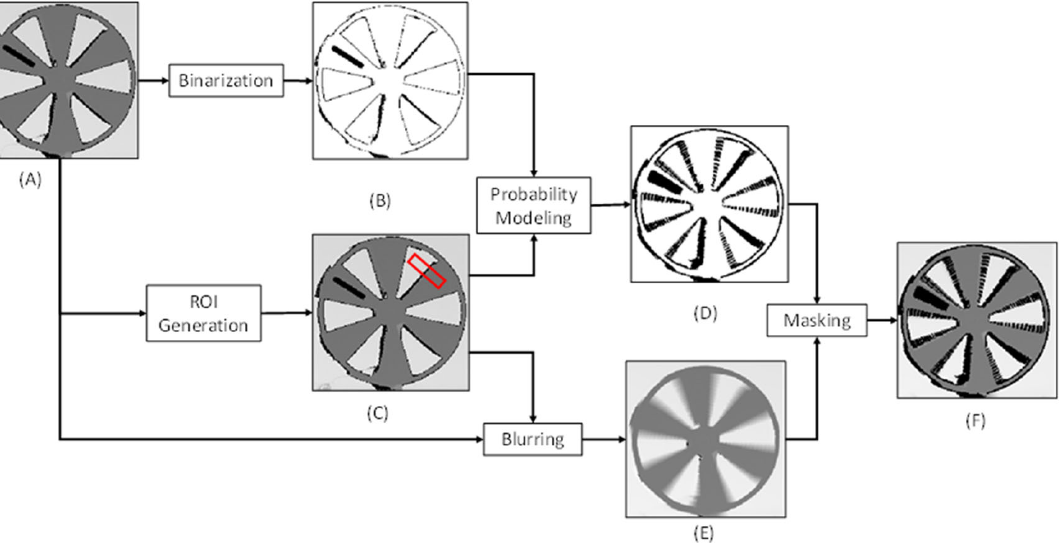
Figure 1. Process for generating synthetic motion blur. ( A ) Initial depth map from ToF sensor; ( B ) Binary depth map; ( C ) Depth map with an example of an ROI for a pixel shown in red. The ROI has been enlarged for visualization purposes; ( D ) Binary depth map after updating the binary depth with the predicted zero value pixels. The zero-value pixels are shown in black and the non-zero value pixels are shown in white; ( E ) Depth map after applying the blur filter; ( F ) Blurred depth map after applying predicted zero value pixels. For visualization purposes, ( A , C , E , F ) are shown within normalized values in the uint8 range.